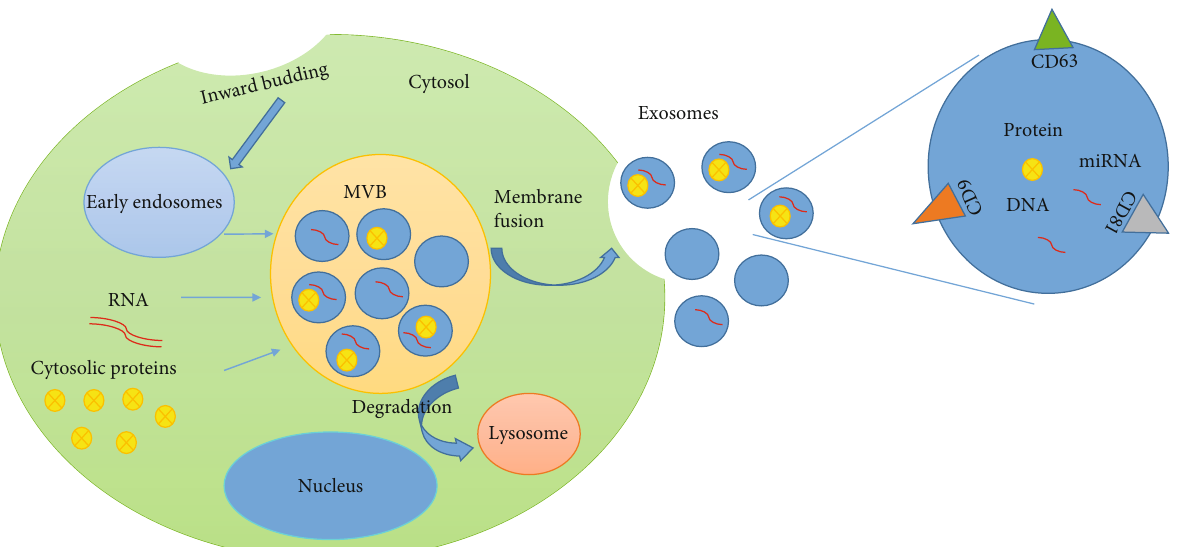
Figure 1: Exosome biogenesis and secretion. First, insertion of the cell membrane leads to the formation of early endosomes, and then, endosomes containing RNA and cytosolic proteins are transformed into MVB structures with dynamic subcellular structures. After that, MVBs can be fused with lysosomes and degraded or secreted by plasma membranes and formed exosomes. Finally, exosomes release their cargo, such as DNA, microRNA, and proteins, into the recipient cell in a variety of ways. MVBs: multivesicular